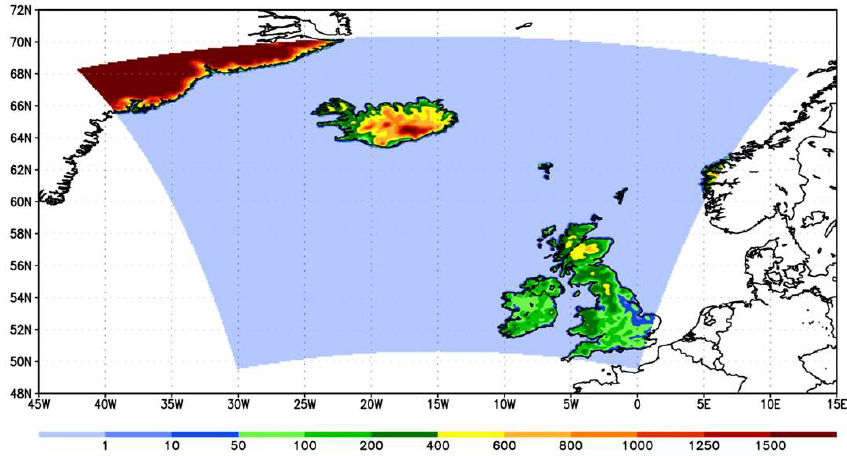
Figure 6. Domain represented as topography height in meters above sea level.